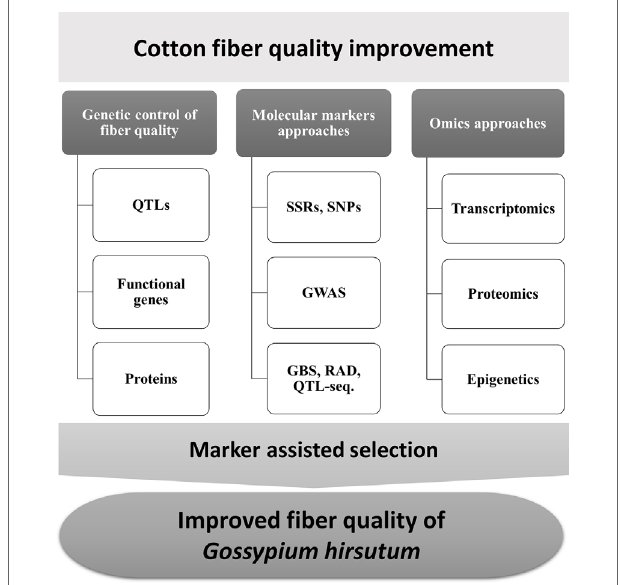
FIGURe 1 | Overview of the strategies for marker-assisted selection (MAS) to improve fiber quality in Gossypium hirsutum .